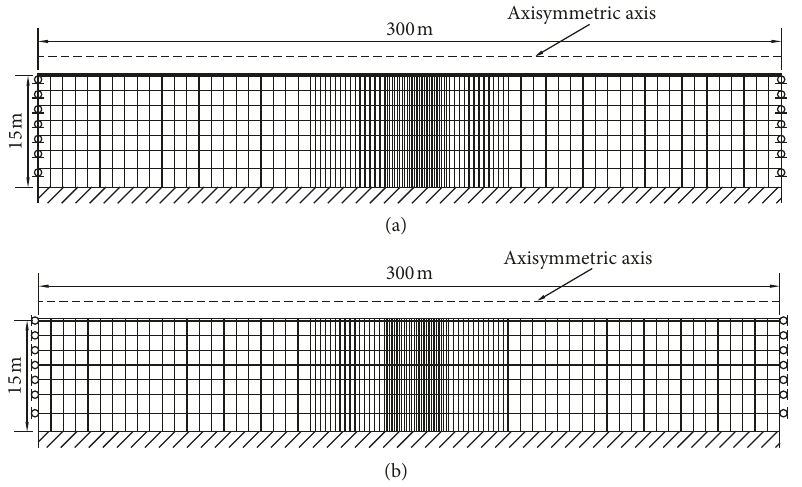
Figure 12: Discretization and boundary conditions of axisymmetric finite element mesh. (a) Longitudinal direction and (b) transverse direction.